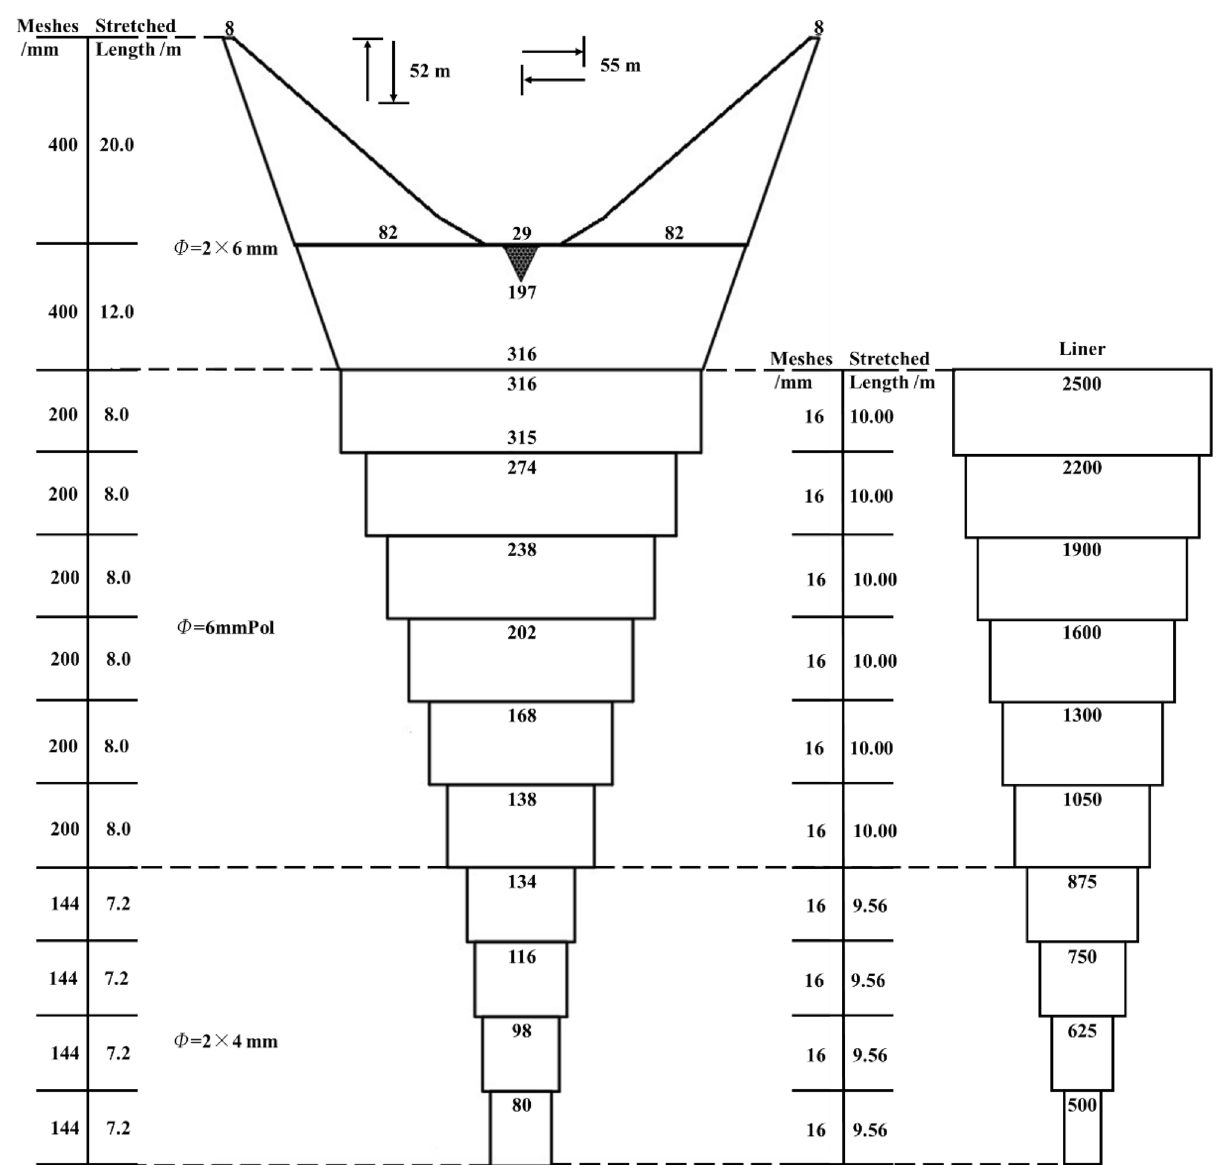
Figure 1. Schematic net plan of Antarctic krill trawl in